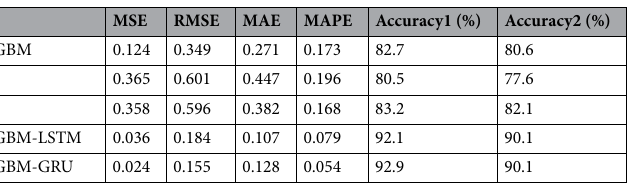
Table 3. Prediction error.